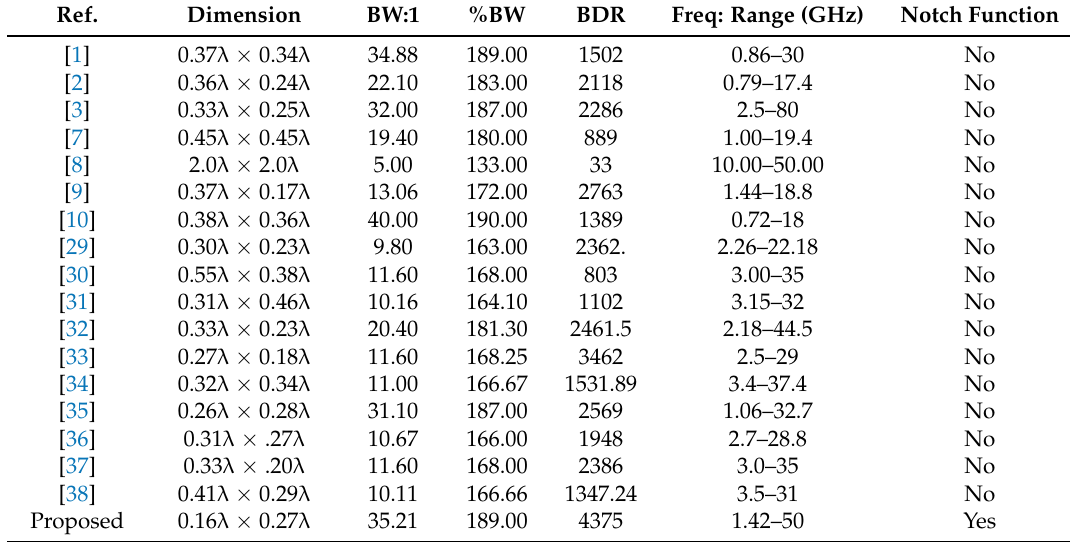
Table 2. Comparison with previously reported SWB